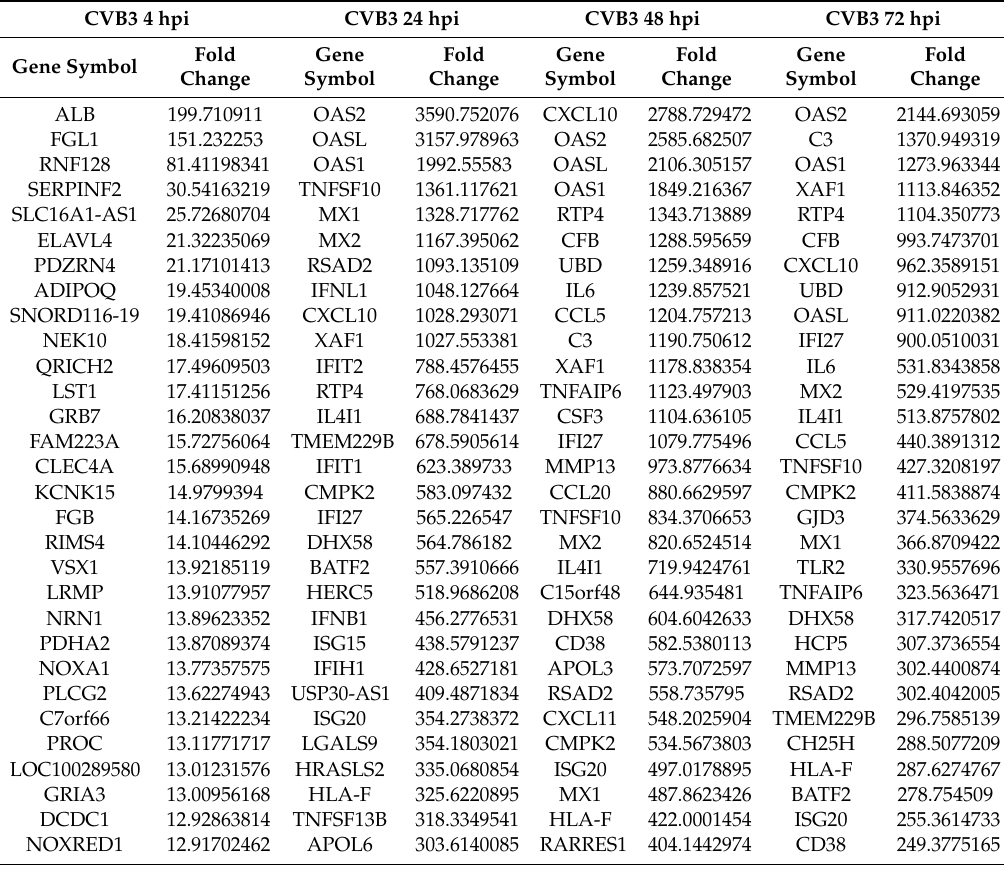
Table 1. Top 30 up-regulated di ff erentially expressed genes in CVB3-infected